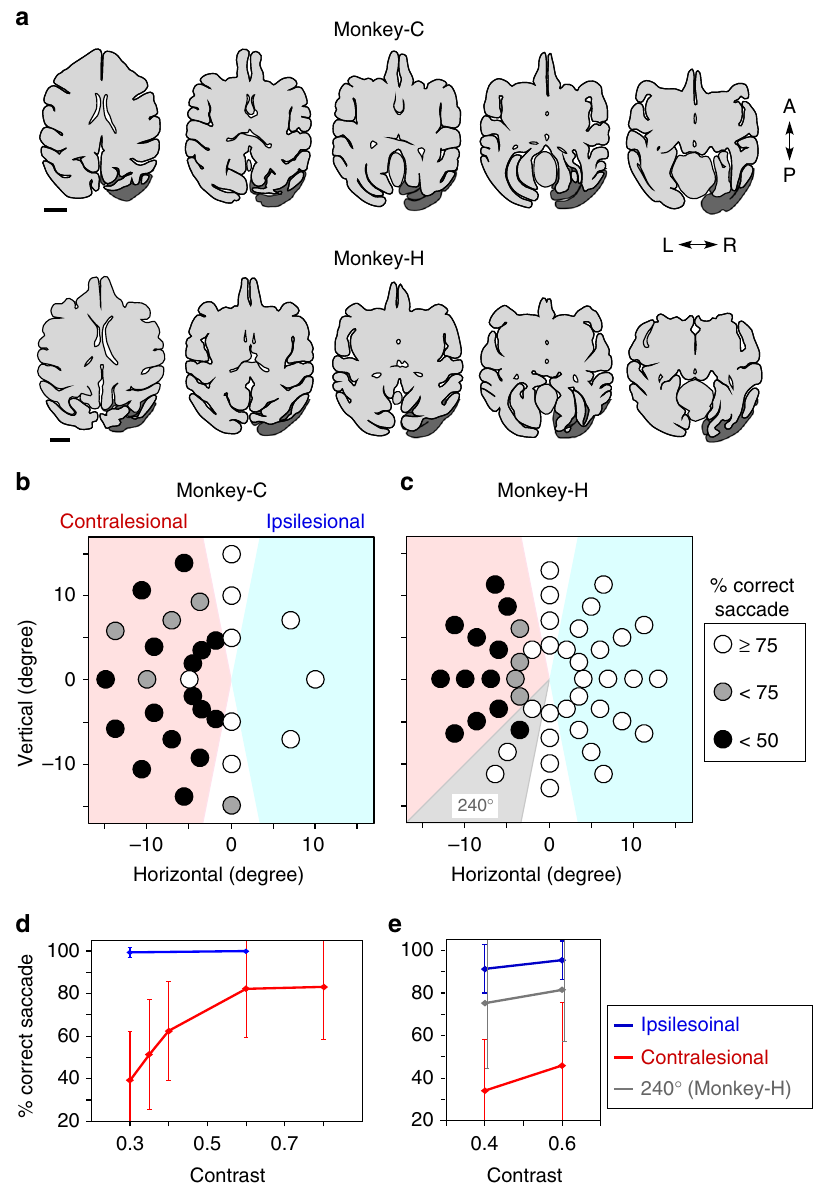
Fig. 1 Unilateral V1 lesion and the affected visual fi elds. a Extent of V1 lesions: drawings of horizontal brain sections traced from the magnetic resonance images (MRI; shown in Supplementary Figure 1). The dark gray areas indicate the estimated lesion sites (see Methods). Note that lesion covered not only the occipital surface but also the calcarine fi ssure. Scale bar: 1 cm. b , c The de fi cit maps: percent correct saccades were plotted. The Michelson contrast of the target was 0.3 for Monkey-C and 0.4 for Monkey-H. The performance for 5 days was averaged (see Methods). d , e Contrast sensitivity: average of percentage of correct saccade to the targets in ipsilesional (blue) or contralesional visual fi eld (red) was plotted against contrast intensity. For Monkey-H, data at 240° (gray) was excluded from the contralesional fi eld. The performances for 5 days were averaged (see Methods). The error bars represent standard deviation